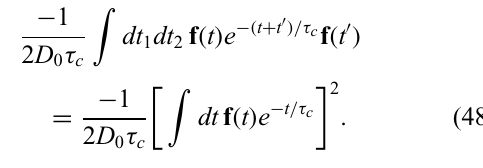
FIG. 3. Nonstationary noise spectrum of a one-dimensional quenched diffusion process of the environmental field fluctua- tions, driven by a one-dimensional Ornstein-Uhlenbeck stochas- tic process. (a) The absolute value of the corresponding spectral density S (ω 1 , ω 2 ) in the frequency basis, the bispectrum given by Eq. (47), is shown. Only the diagonal ω 1 = ω 2 contains the stationary component of the noise spectrum that is dominant at long times after the quench. As the stationary component is − ω ) , we plot it by replacing the δ(ω − ω ) function ∝ δ(ω 1 2 1 2 with a nondivergent Gaussian function for presentation purposes. The inset shows a surface colored map of the bispectrum with contour lines in white. (b) The corresponding generalized, non- stationary noise spectrum S ((cid:4)) , given in the noise eigenmode basis | (cid:4)) that diagonalizes the noise